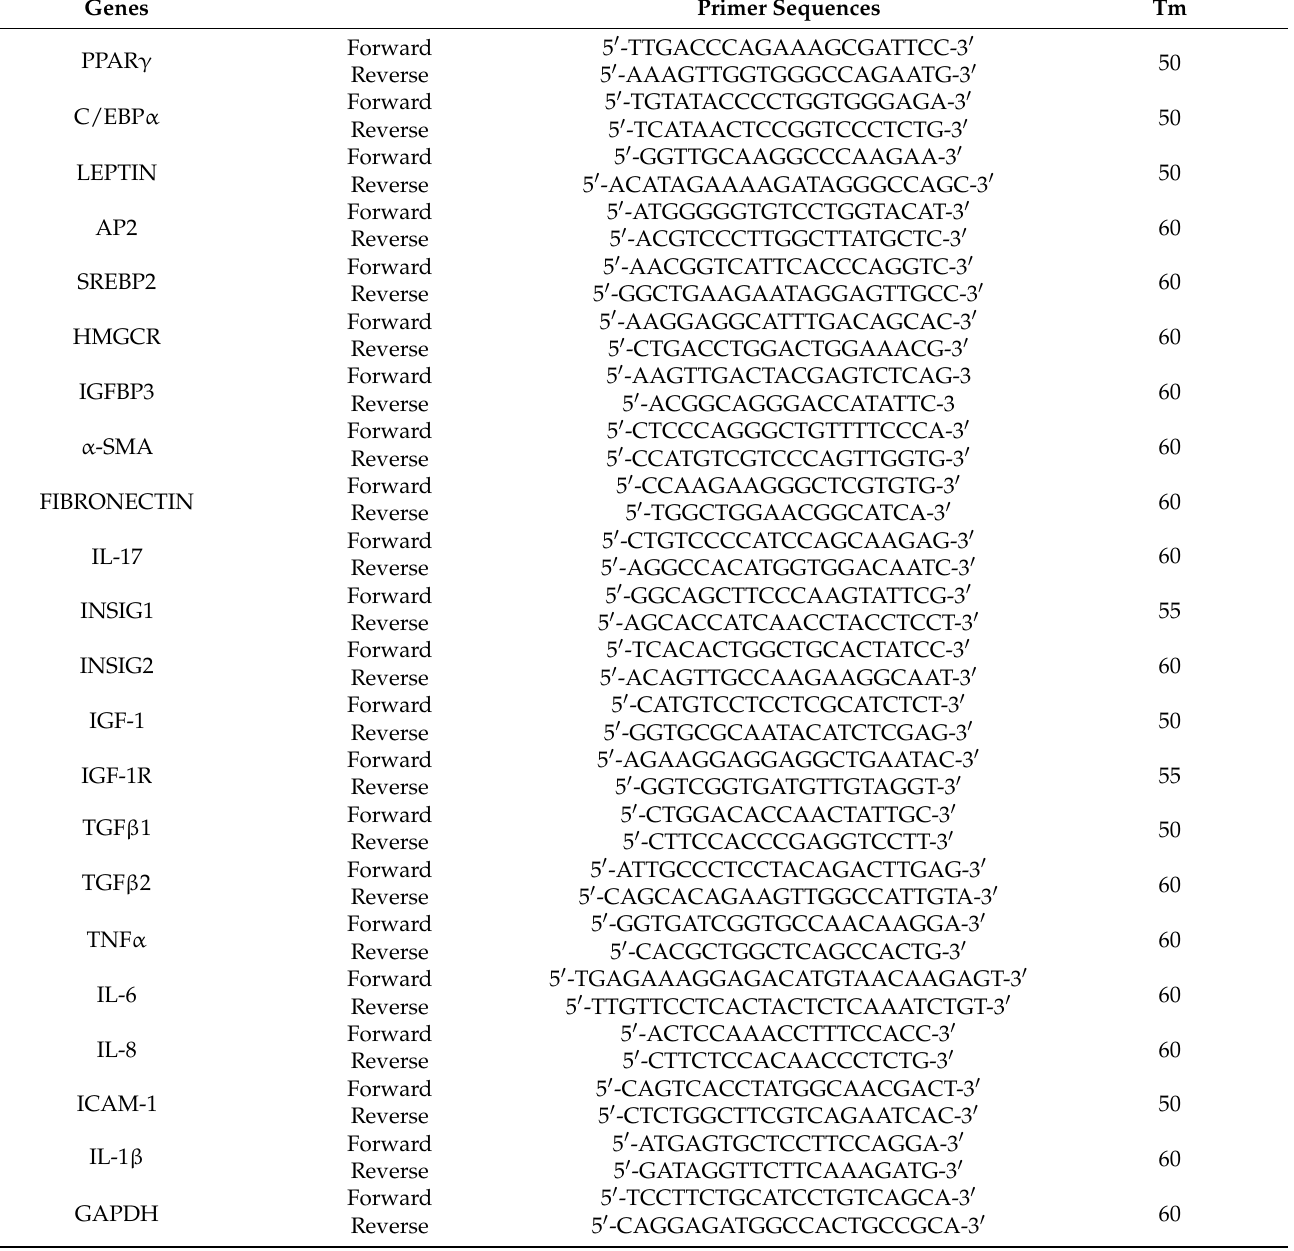
Table 1. Human primer sequences using quantitative real-time polymerase chain